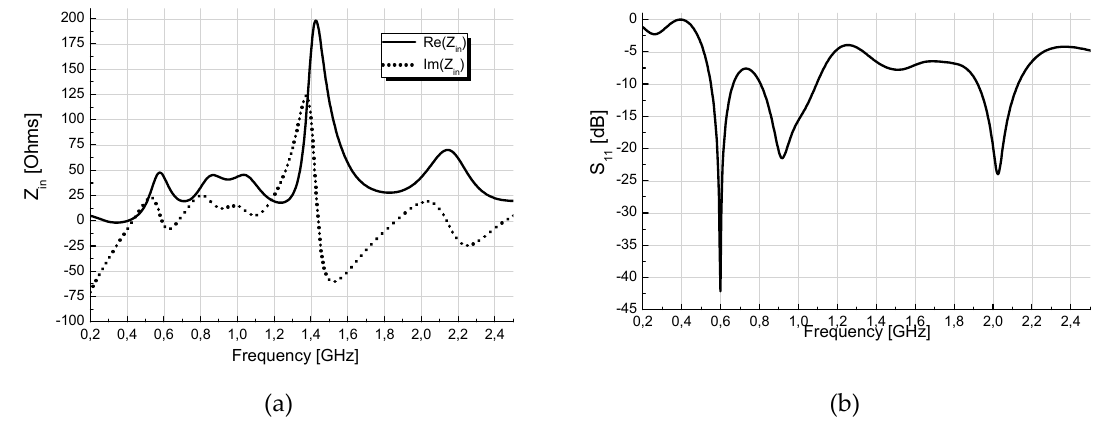
Figure 6. Antenna_2: ( a ) real and imaginary parts of the input impedances of its similar elements, ( b ) signal scattering coefficient at each element’s input considering a 50 Ω port.